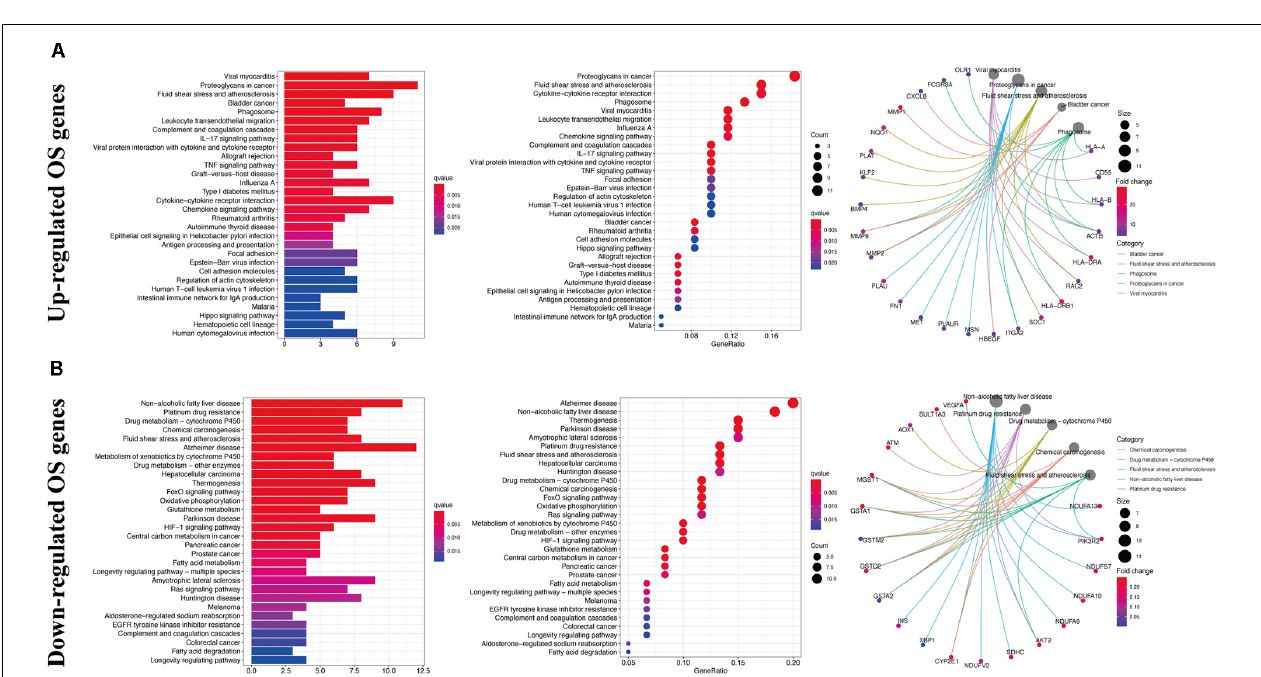
FIGURE 4 | Kyoto encyclopedia of genes and genomes enrichment analysis of DEOGs. (A) Top 30 classes of KEGG enrichment terms about up-regulated DEOGs. (B) Top 30 classes of KEGG enrichment terms about down-regulated DEOGs.